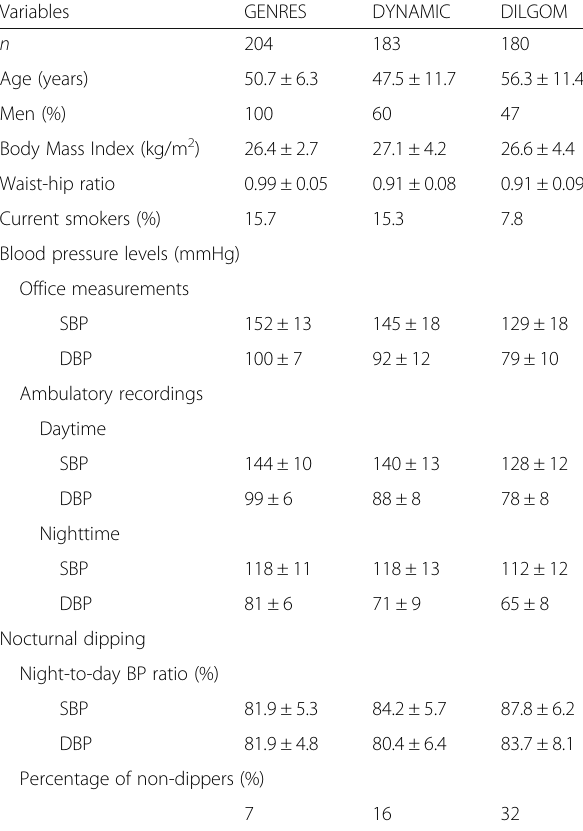
Table 1 Clinical characteristics of the discovery cohort (GENRES) and replication cohorts (DYNAMIC and